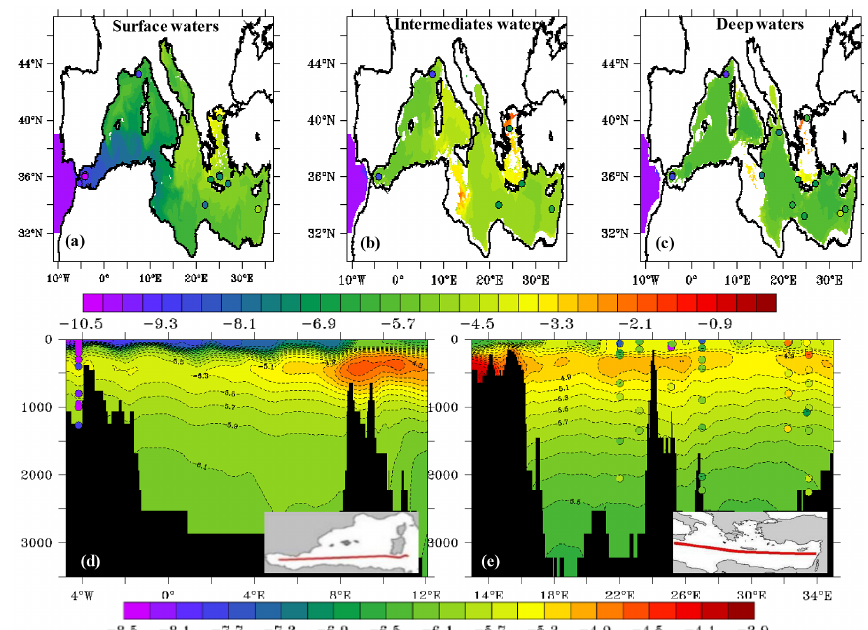
Figure 5. Output of model from EXP2 ( t = 3 months) at the steady state. Upper panel: horizontal maps for surface waters (a) , interme- diate waters (b) , and deep waters (c) . Lower panel E–W section in WMed (d) , and EMed (e) , whereas colour-filled dots represent in situ observations from Tachikawa et al. (2004), Vance et al. (2004) and Henry et al. (1994). Both use the same colour